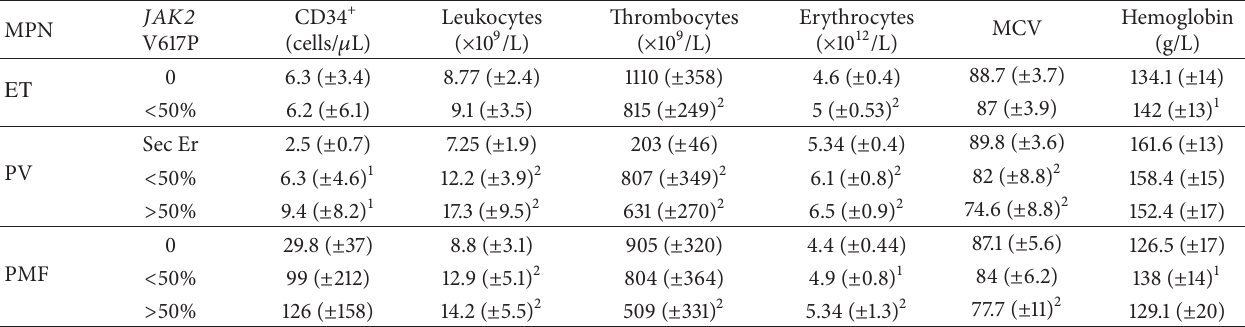
Table 1: Blood test results of examined MPN patients according to JAK2 mutant allele